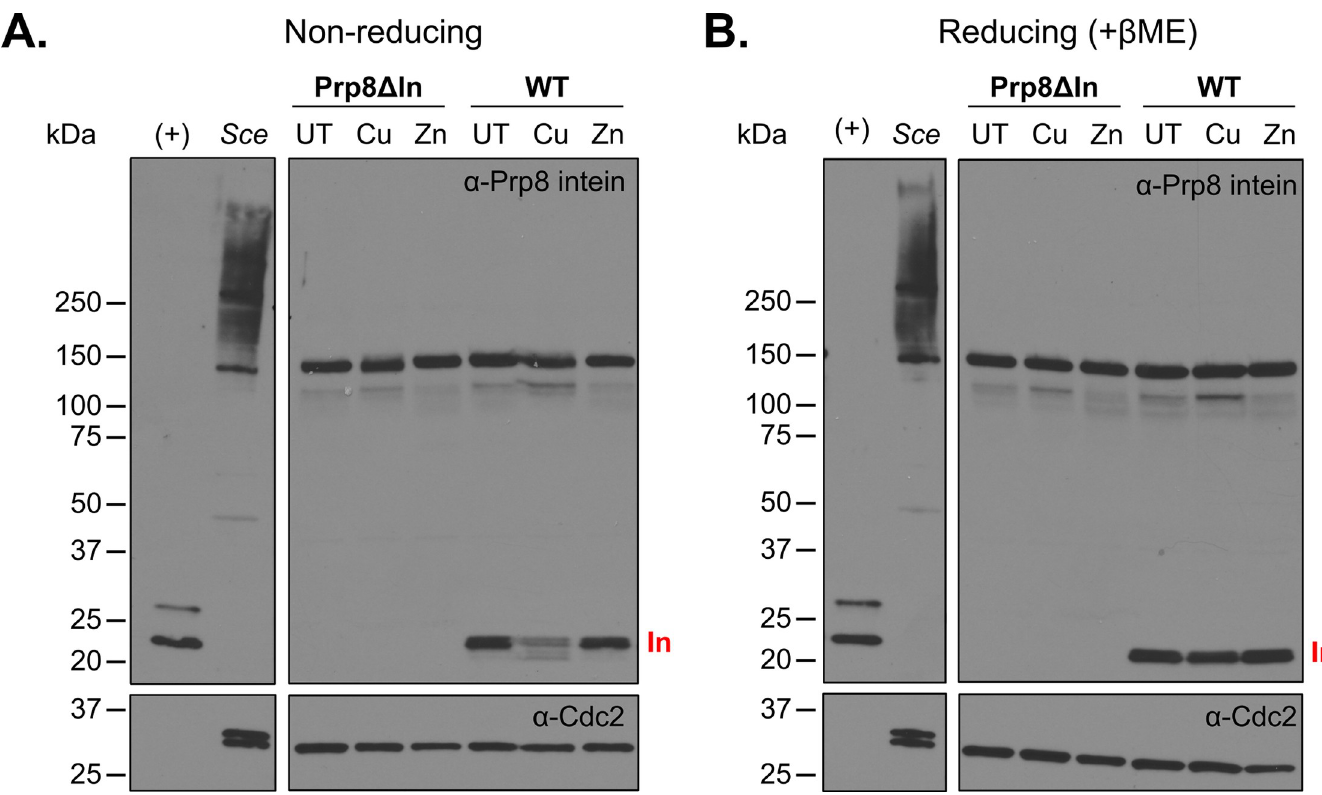
Fig 6. Native protein splicing in Cne is inhibited by copper. (A) Copper treatment shows decreased intein (In) levels under nonreducing conditions. Cne (WT) and an inteinless strain (Prp8 Δ In) were grown in defined media supplemented with 1 mM CuSO 4 or 1 mM ZnSO 4 for 3 h. Top blot is probed with Prp8 intein antibody, and the bottom blot is probed with Cdc2 antibody as a loading control. Intein bands at approximately 20 kDa often appear as doublets because of different oxidation states of cysteines. Bands migrating around 150 kDa that appear in the Prp8 Δ In and WT strain have not been identified, whereas bands from Sce lysate may be related to the Vma1 intein. Lanes are as follows: (+), 2.5 ng of overexpressed pET47b Cne Prp8 intein in E . coli lysate; Sce , 10 μ g of soluble S . cerevisiae extract; UT, unsupplemented SC media; Cu, SC media + 1 mM CuSO 4 ; Zn, SC media + 1 mM ZnSO 4 . All Cne lysates contain 20 μ g of soluble protein. (B) Reducing conditions alleviate splicing inhibition in vitro. Blots are as in panel A but treated with β ME in the loading dye. The reducing conditions in the lysate are sufficient to cause splicing in vitro and the intein band reappears. β ME, β -mercaptoethanol; Cdc2, cyclin-dependent kinase 1; Cne , C . neoformans ; Prp8, pre-mRNA processing factor 8; SC, synthetic complete; Sce , Saccharomyces cerevisiae ; UT, untreated; WT, wild